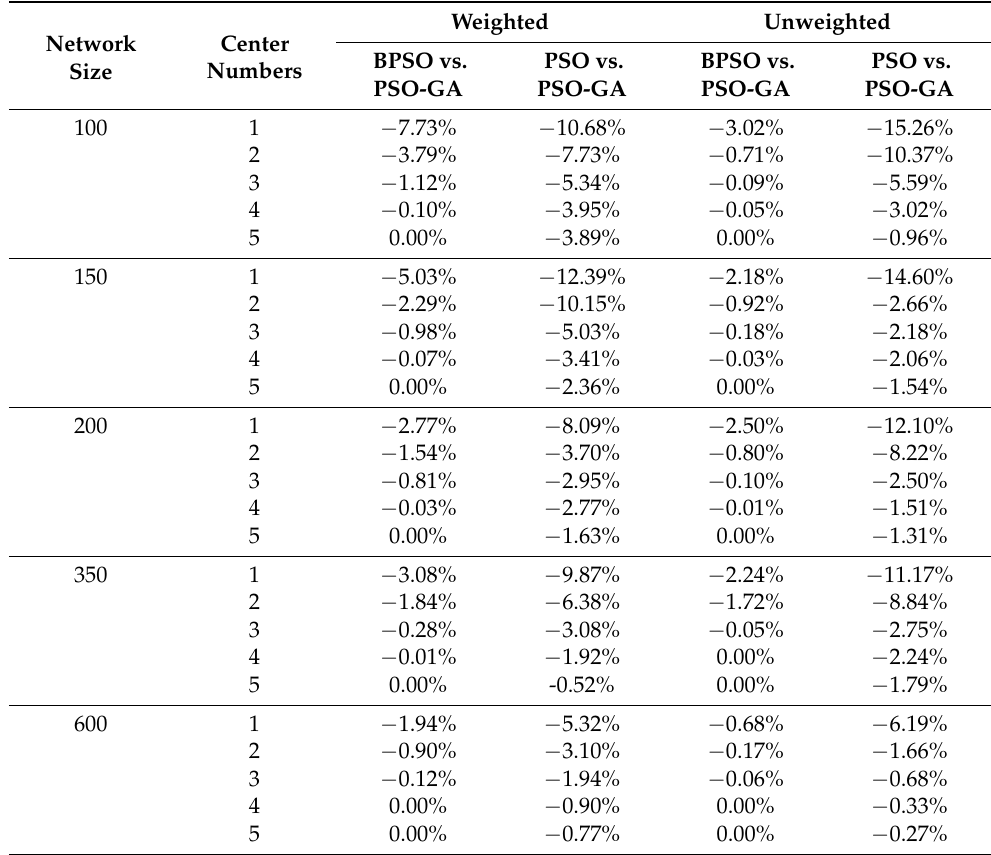
Table 10. The comparative total cost comparison for unweighted and weighted logistics network of each solver compared to PSO-GA